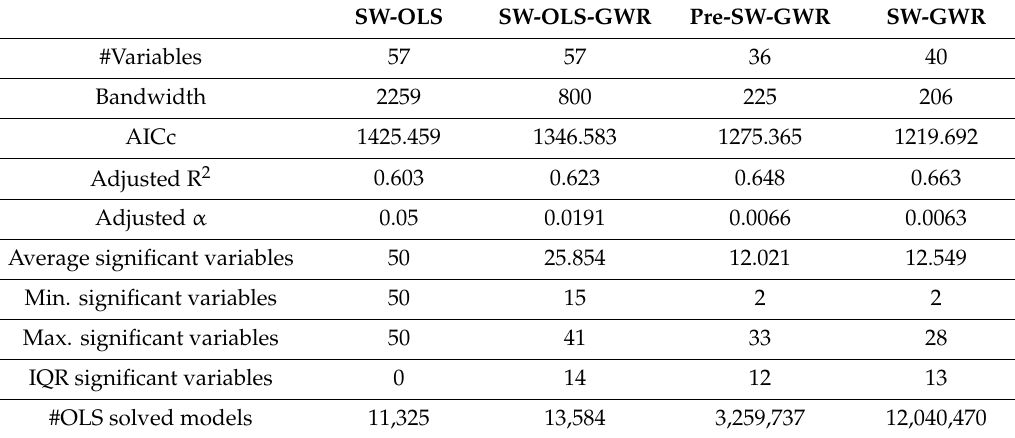
Table 3. Comparison between the three methods used for selecting